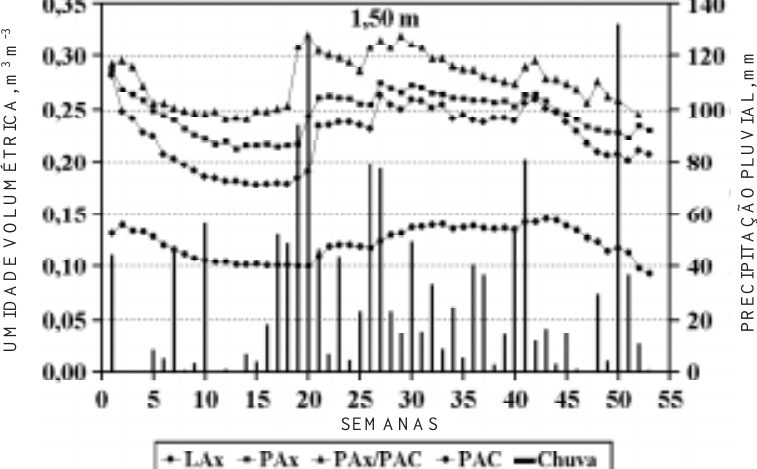
Figura 9. Variação da umidade nos solos Latossolo Amarelo argissólico (LAx), Argissolo Amarelo (PAx), solo transicional PAx/PAC e Argissolo Acinzentado (PAC), nas 53 semanas de avaliação, na profundidade de 1,50 m, e precipitação pluvial no período, em uma toposseqüência em tabuleiro do estado da Bahia.